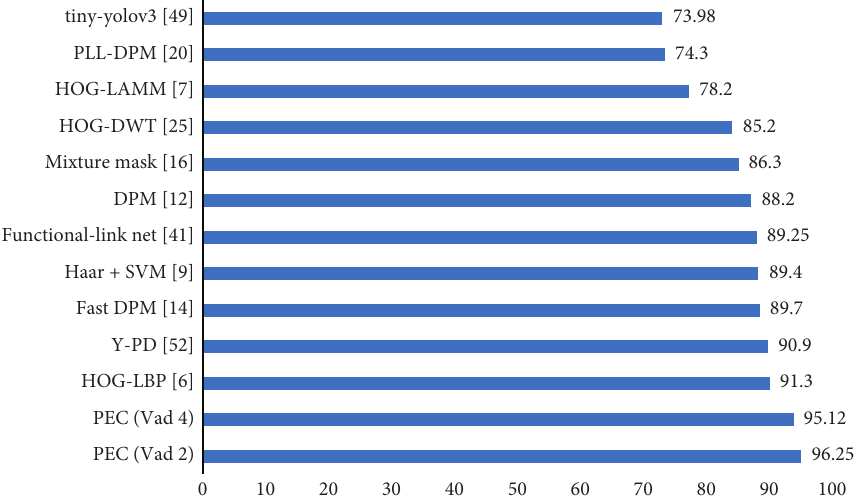
Figure 11: Performance comparison between the proposed approach and the state-of-the-art approaches.